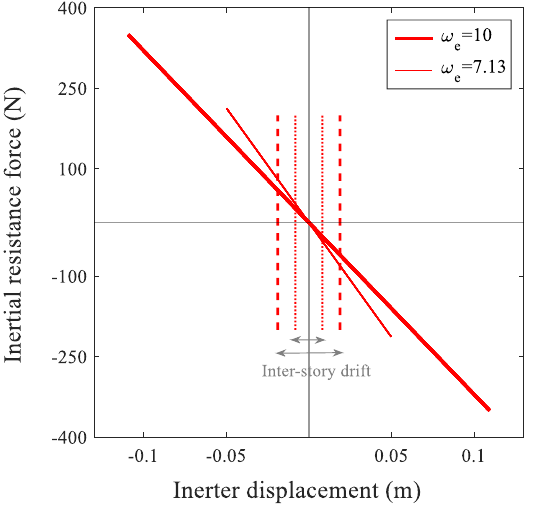
Figure 12. ATMID inertial force-displacement correlation curve at frequencies of 10 and 7.13 (rad/s).